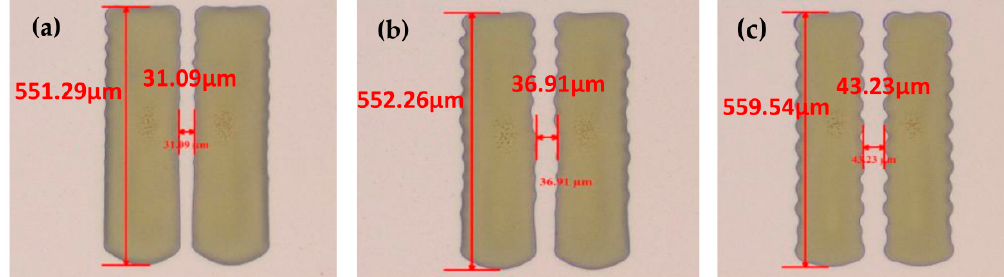
Figure 2. Inkjet-printed Ag S/D electrodes based on Al:Nd/Al2O3:Nd/a-IGZO with different drop spaces: ( a ) 35 μ m; ( b ) 40 μ m; ( c ) 45 μ m.